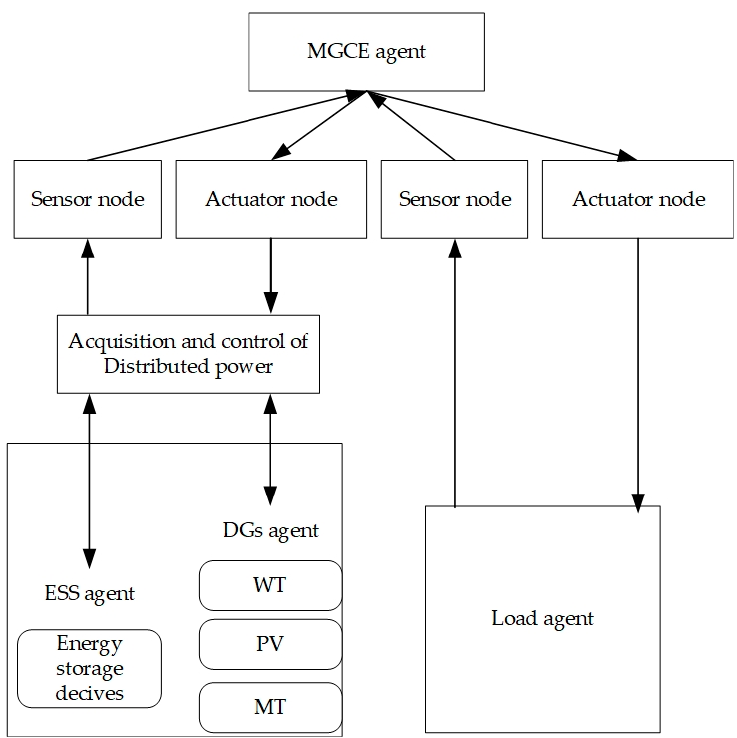
Figure 3. The process of the MGCE layer.